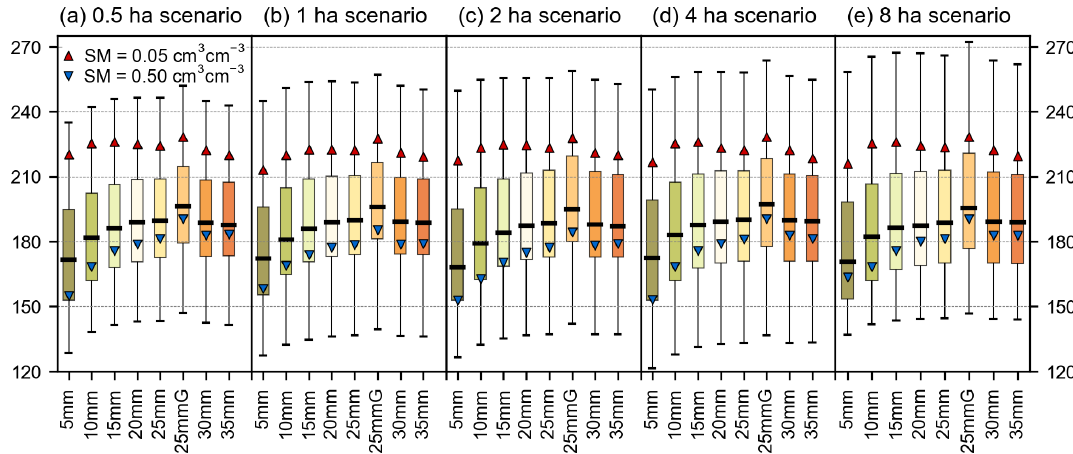
Figure 3. Boxplots of R86 in metres for different moderator types and size of the inner area, i.e. (a) 0.5, (b) 1, (c) 2, (d) 4, and (e) 8ha. Each boxplot refers to one moderator type (100 combinations of SM) and shows the minimum and maximum values with whisker caps, the interquartile range with bars, and the median with a black line. Blue and red triangles show R86 values for homogeneous SM of 0.05 and 0.50cm 3 cm − 3 , respectively.